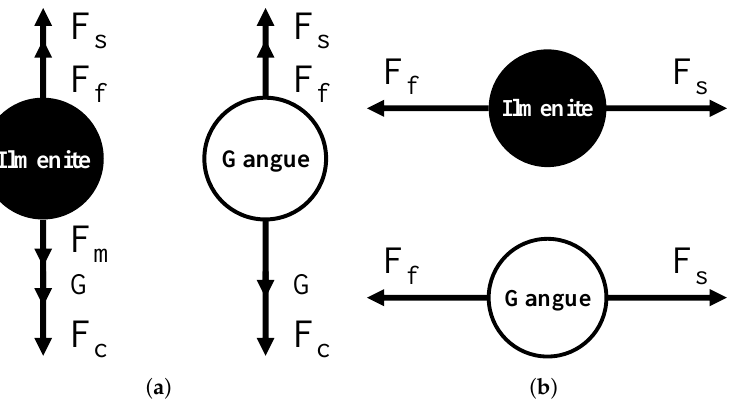
Figure 10. Schematic diagram of the force of mineral particles; F s —the fluid drag force; F f —the friction force; F m —the magnetic force; F c —the centrifugal force; G—gravity force. ( a ) Radial force, ( b ) Axial force.